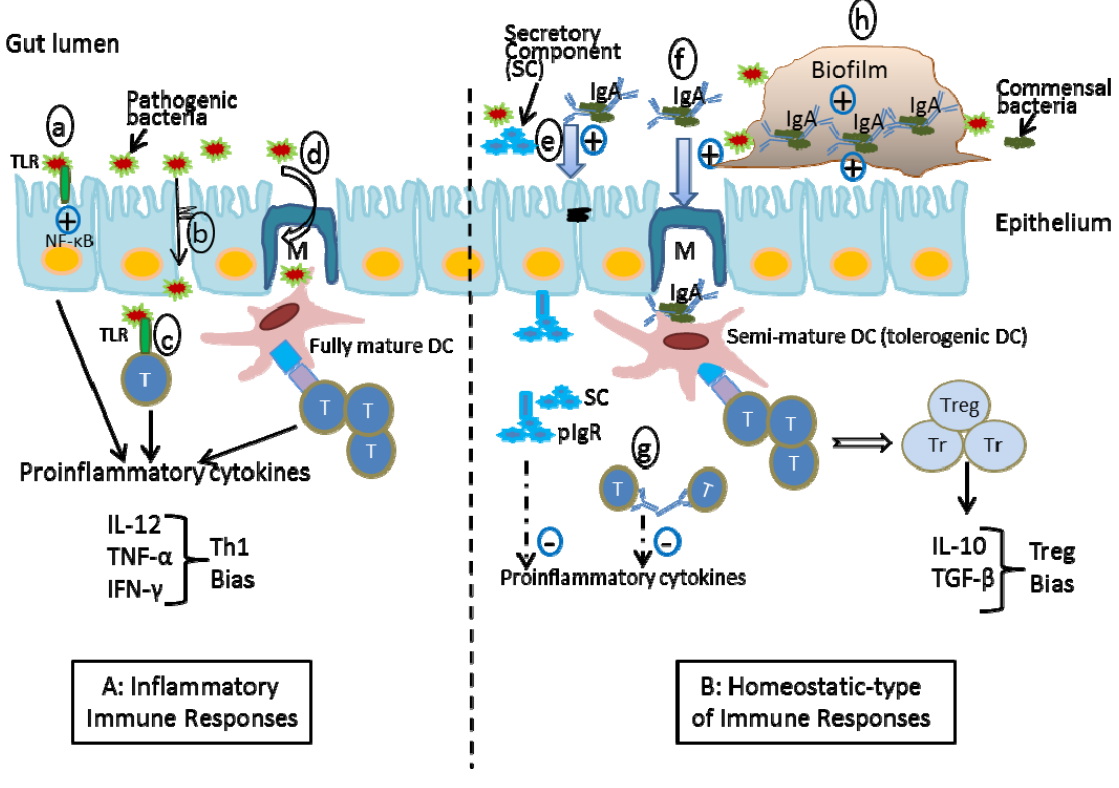
Figure 2. Proposed mechanisms of the protection of SIgA-coated bacteria and SIgA-based immune complexes in the intestinal mucosa A . Inflammatory immune responses: pathogens trigger inflammation by activating TLR signals ( a ), disrupting the intestinal barrier ( b ), and activating T-cells by pathogens ( c ) and by fully mature dendritic cells (DCs) ( d ). B . Homeostatic-type immune responses: Non-pathogenic bacteria coated by SIgA down-regulate local inflammation by reinforcing the barrier function ( e ), inducing regulatory T cells ( f ), directly interacting with T-helper cells ( g ), and biofilm formation ( h ). The combination of these events contributes to the maintenance of